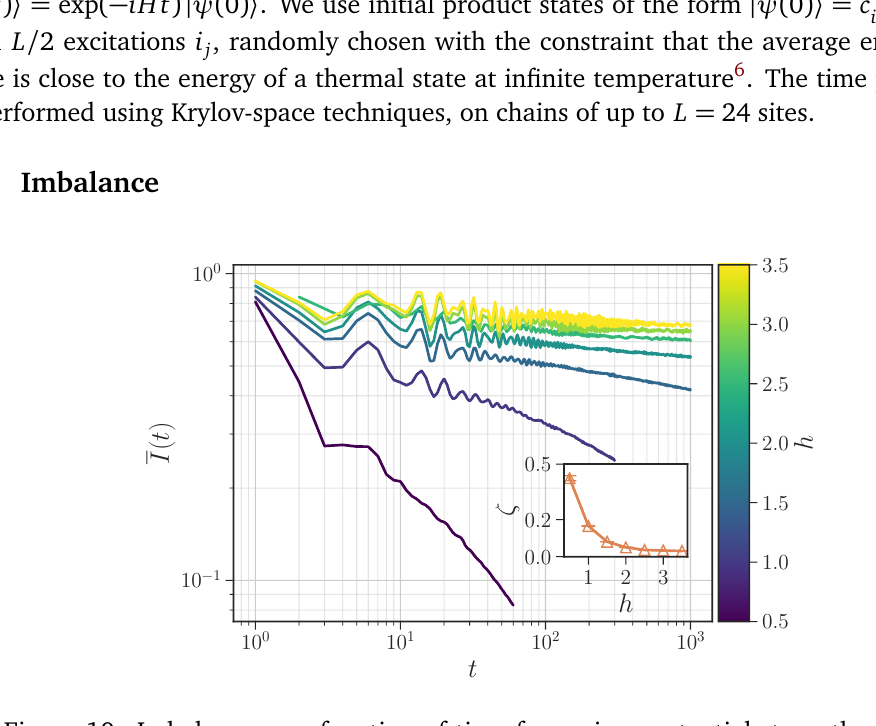
Figure 10: Imbalance as a function of time for various potential strengths, for the chains of L = 22 sites. Averaging is performed over initial high energy product states and field configurations. Inset: exponent of the power-law decay of the imbalance as a function of potential strength (see